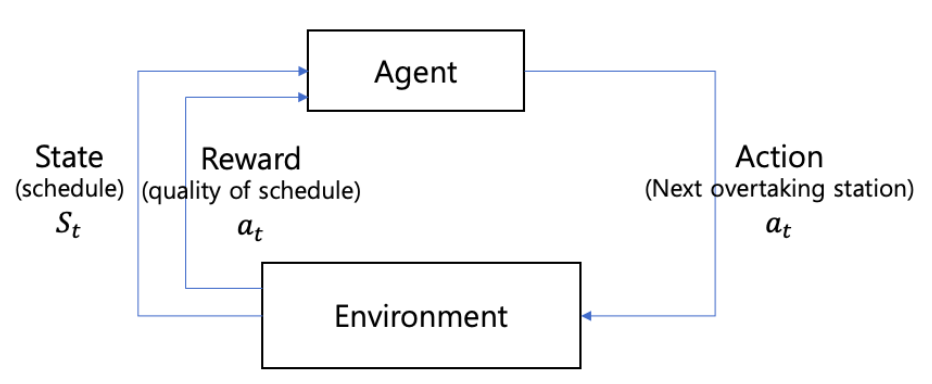
Figure 1. The proposed Markov decision process (MDP)